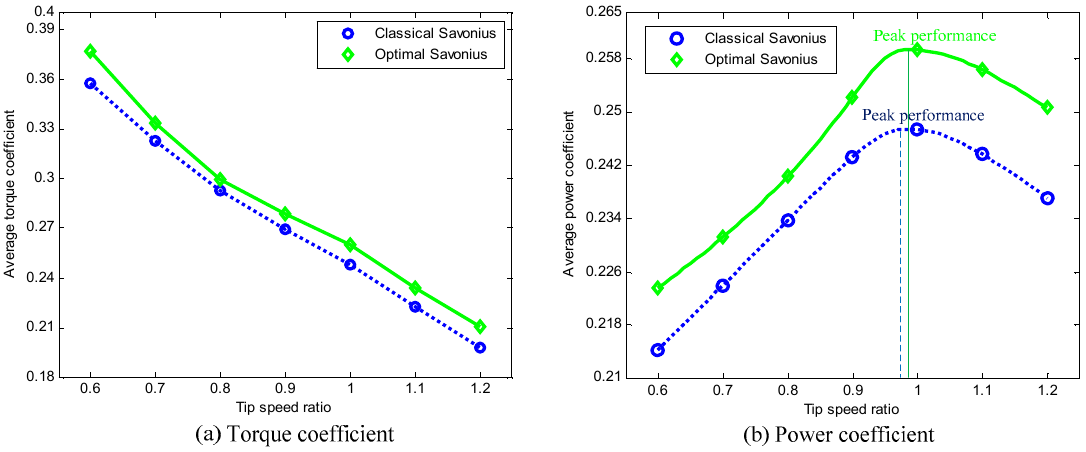
Figure 22. Comparison of ( a ) average C m and ( b ) average C p at different TSRs for the classical Savonius and the optimal Savonius.